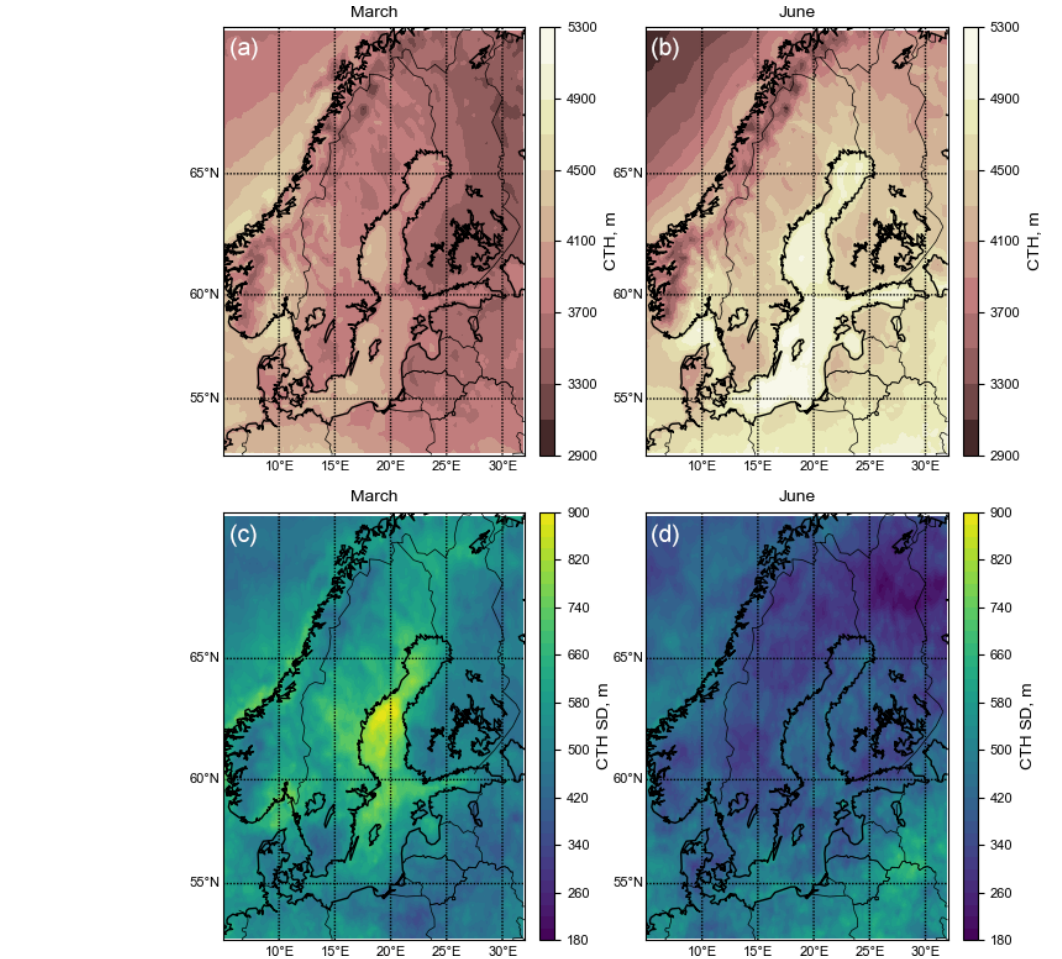
Figure 5. Monthly mean CTH 1982–2015 (a, b) and standard deviation of CTH 1982–2015 (c, d) for March (a, c) and June (b, d) . Based on CLARA-A2 climate data